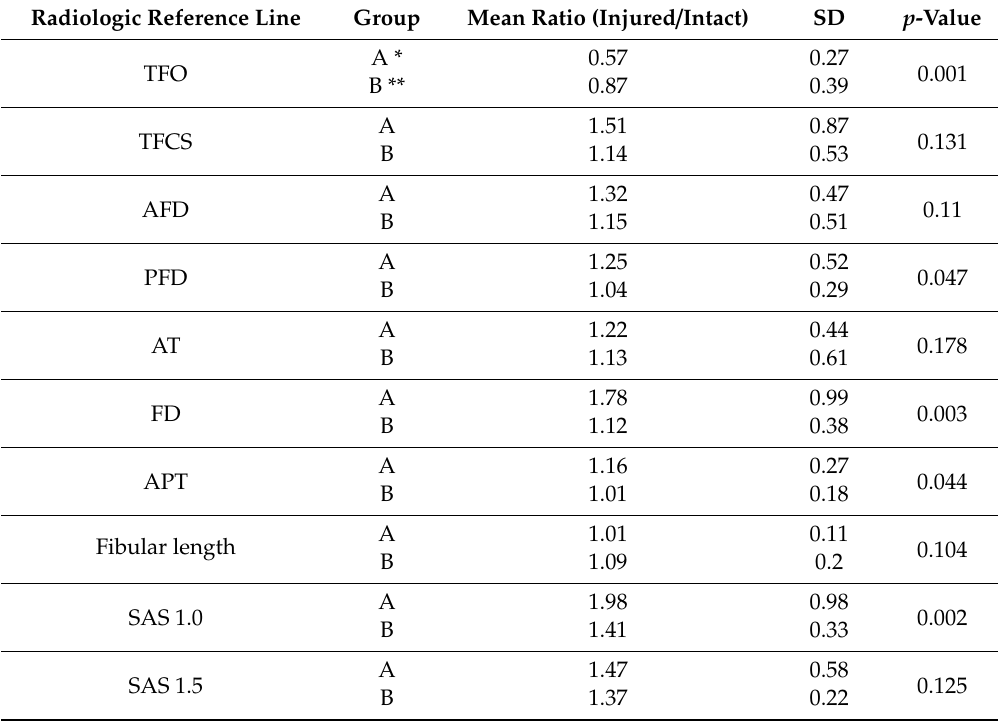
Table 2. The ratio of measurements of ankle with syndesmotic injury and intact ankle.